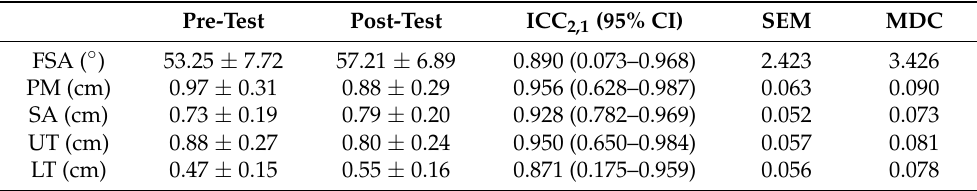
Values represent mean ± standard deviation; PM: pectoralis major; SA: serratus anterior; UT: upper trapezius; LT: lower trapezius; FSA: forward shoulder angle; ICC: intraclass correlation coefficients; SEM: standard error of measurement; MDC: minimal detectable change (n =